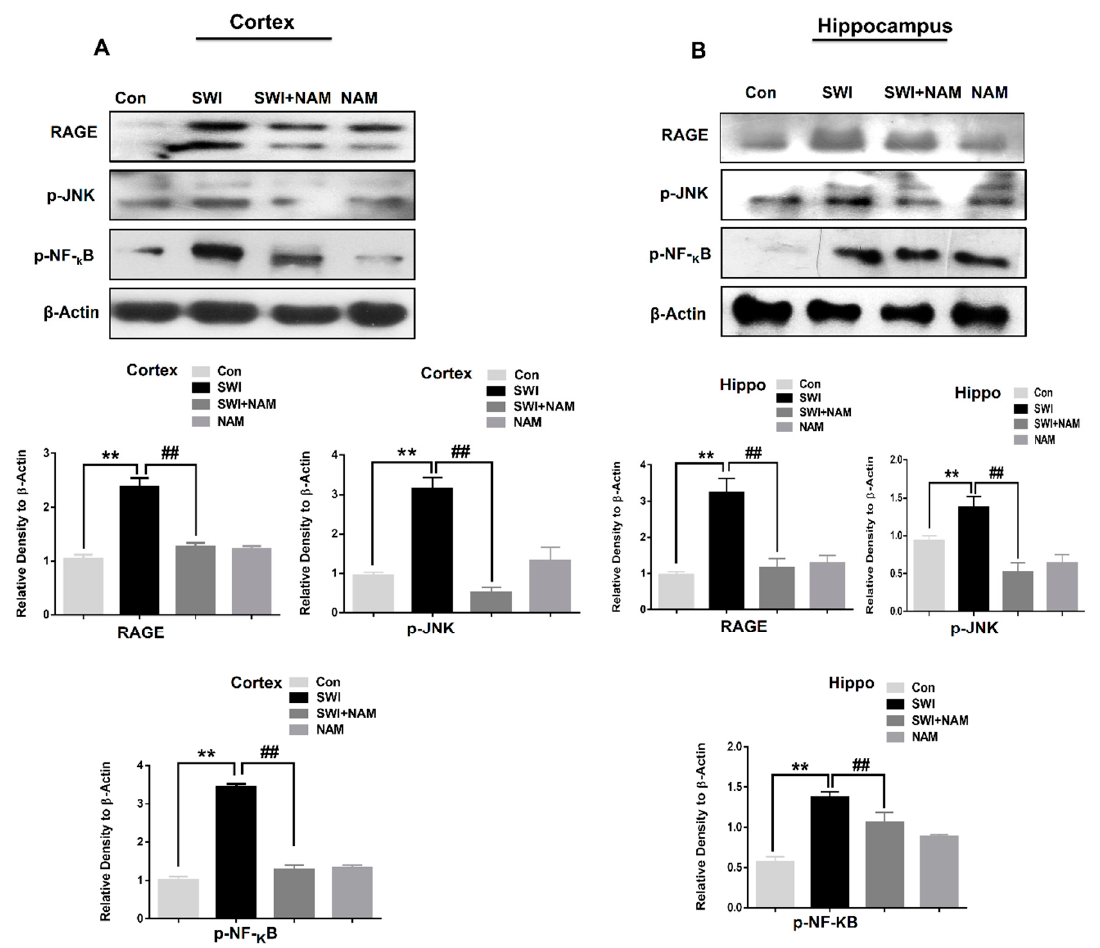
Figure 2. Nicotinamide (NAM) attenuates the expression level of receptor for advanced glycation end-products (RAGE), p-JNK, and p-NF- κ B in the mouse brains. ( A , B ). Representatives immunoblots and histograms showing the expression level of RAGE, P-Jun N-terminal kinases (JNK), and p-NF- κ B in the ipsilateral cortex and hippocampus region of the brain injury and brain injury plus treated groups ( n = 8). The β -actin was used as a loading control. The sigma gel software was used for the quantification of protein bands. The values are the mean ± SEM. a P -value less than 0.05 was considered significant. All the values were taken from three independent experiments. One-way ANOVA followed by post hoc analysis for the comparison of the values. P < 0.05 was considered statistically significant. The symbols * P < 0.05, and ** P < 0.01 represent significant differences between control and SWI; # P < 0.05, and ## P < 0.01 represent significance differences between SWI and SWI plus NAM.